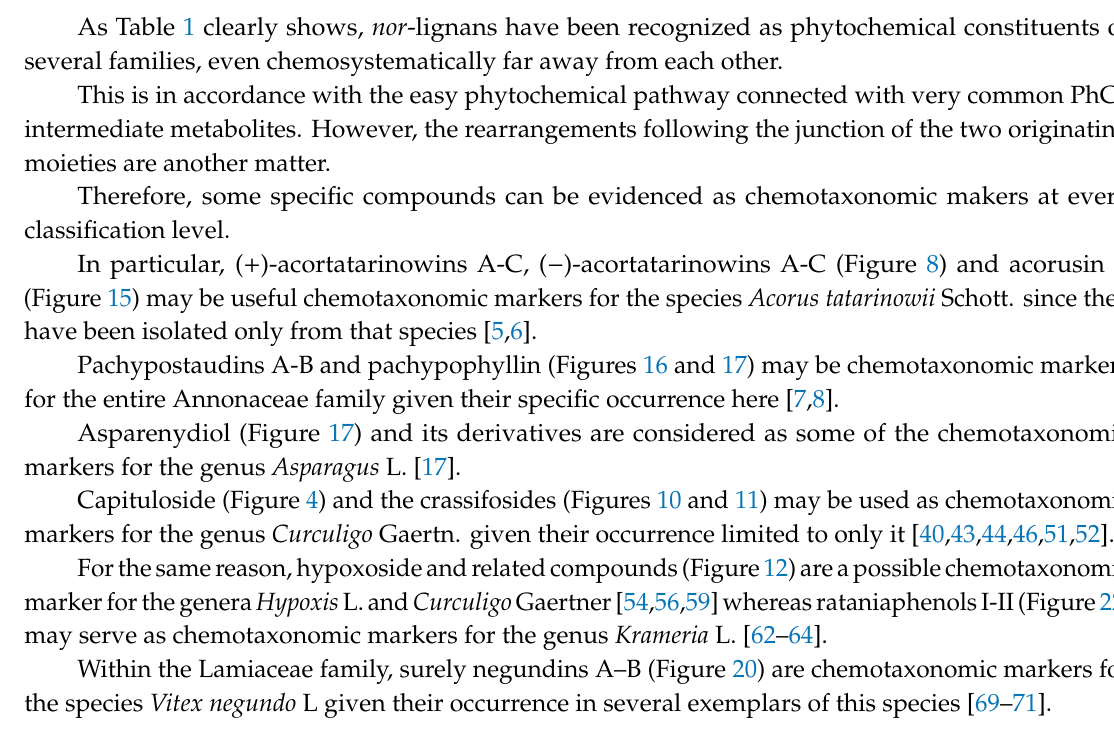
Figure 24. Isolated nor -lignans in the plant kingdom—part 23.